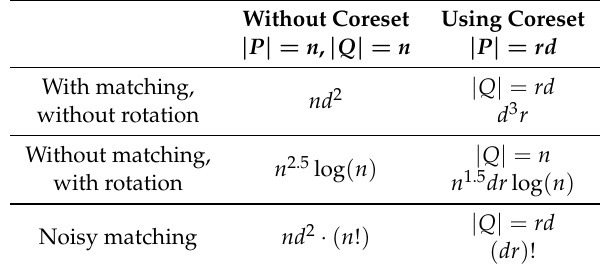
With matching, without rotation Without matching, with rotation Noisy matching nd 2 · ( n ! )